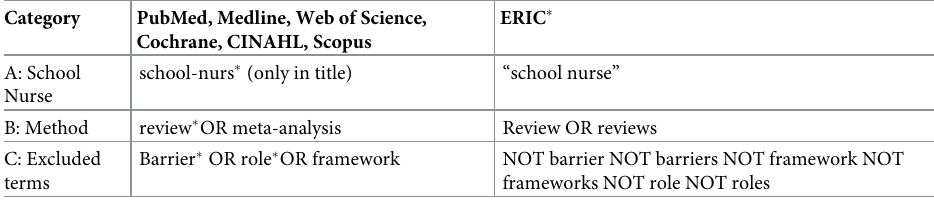
Table 2. Terms used in systematic database literature